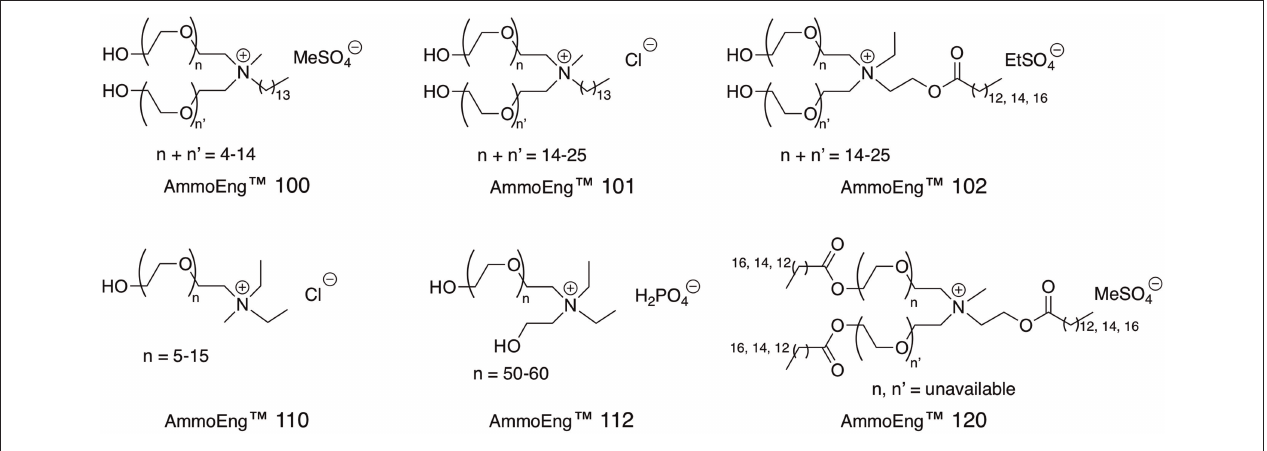
FIGURE 2 | The AmmoEng TM series of ionic